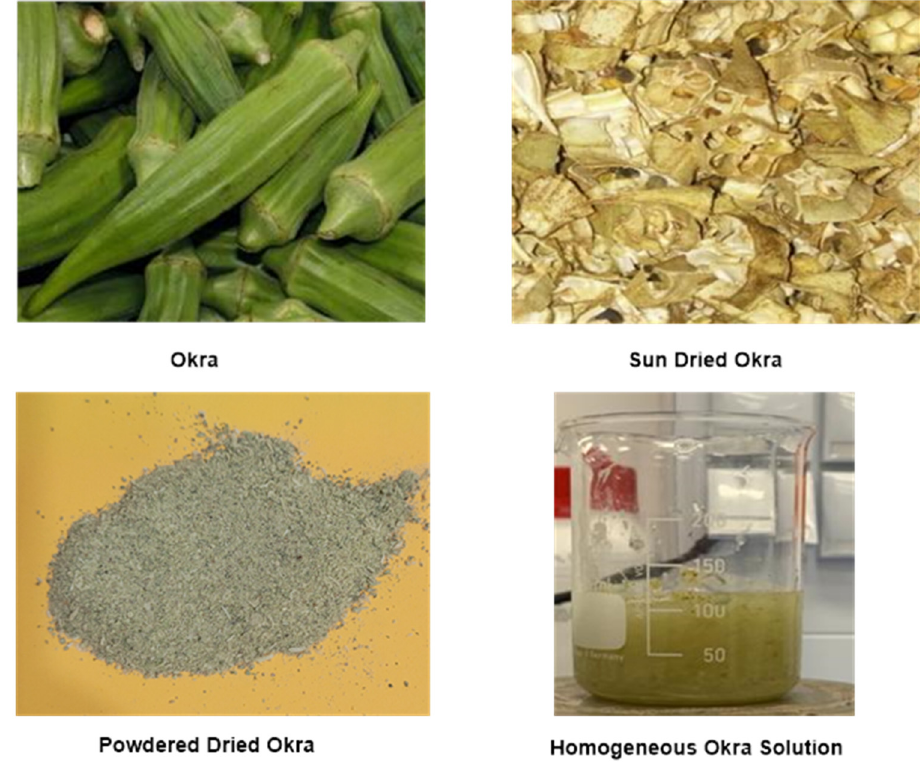
Figure 1. Okra preparation process.